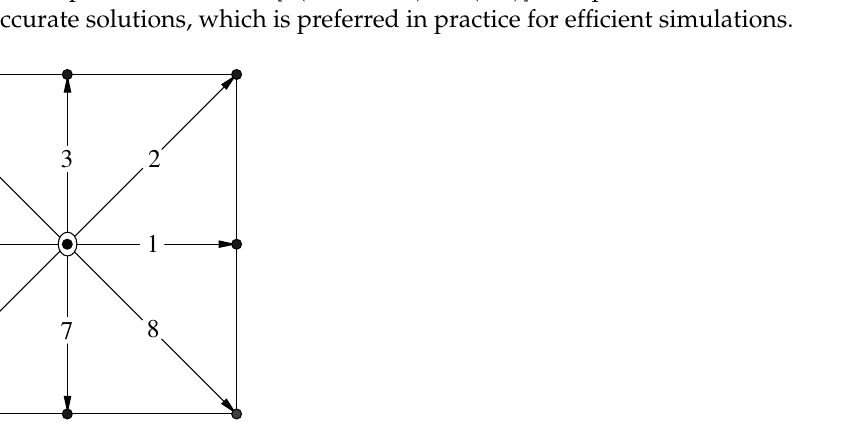
Figure 1. Two-dimensional square lattice for nine-particle velocities, which are labelled by Numbers 1–8 for directions and 0 for still particle